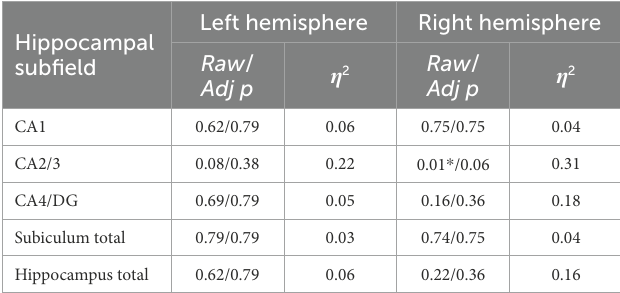
TABLE 2A Group differences in volumes between MDD patients and healthy controls.